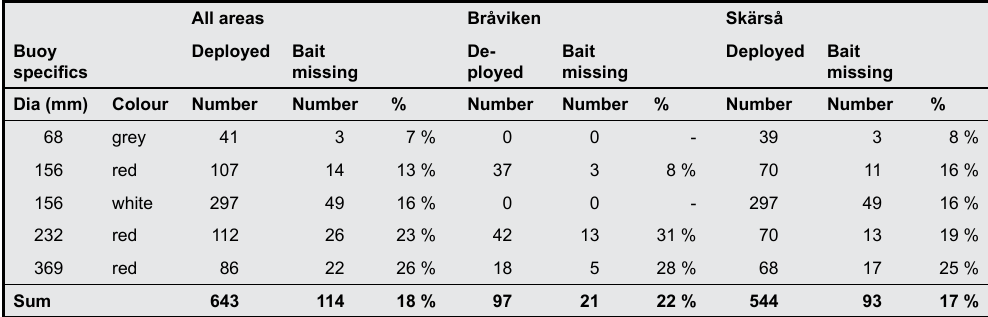
Table 3. Number of buoys set and bait that went missing (possibly taken by seals) during the field experiment with baited buoys, in relation to buoy diameter, buoy colour and camera present / ab -